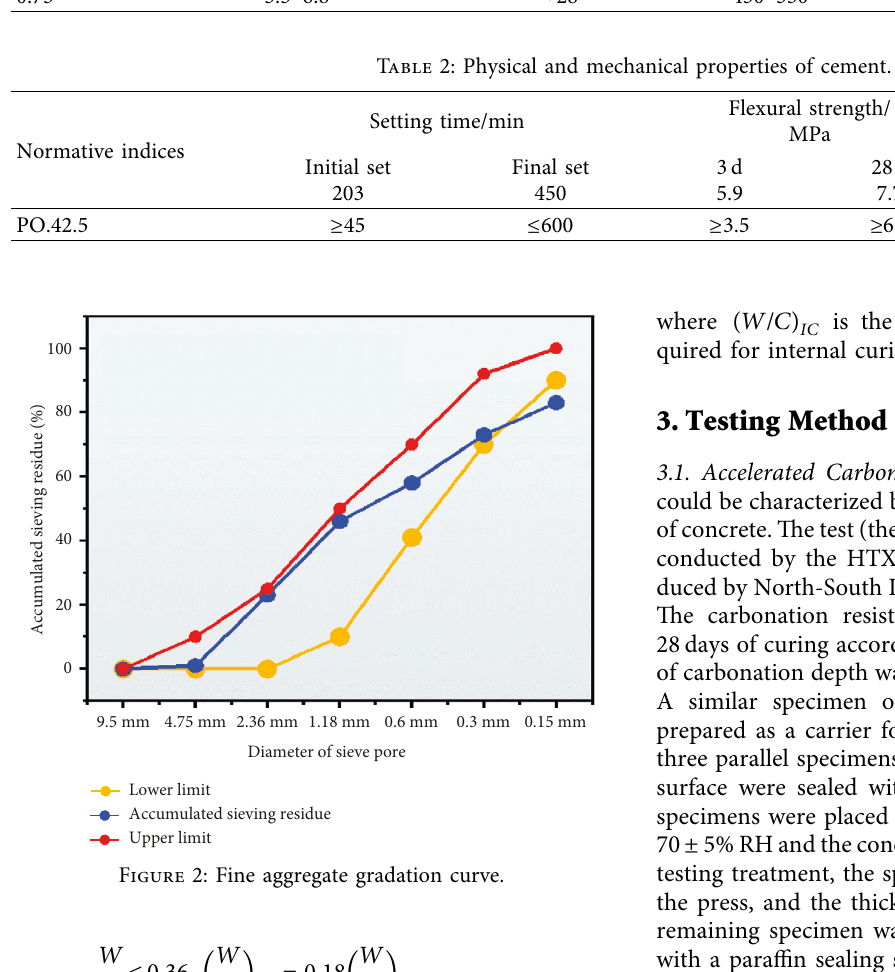
Figure 2: Fine aggregate gradation